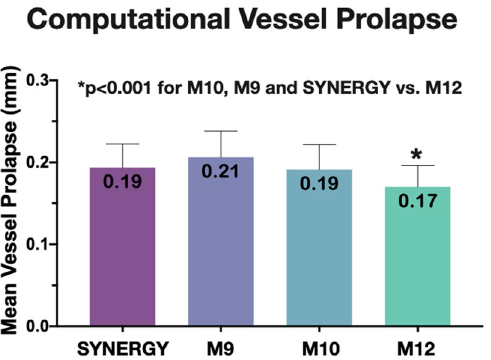
Figure 7. Computational vessel prolapse. Vessel prolapse across different stent designs decreased significantly with increased number of peaks (12-peak < 10-peak < 9-peak). Vessel prolapse for SYNERGY is similar to M10;